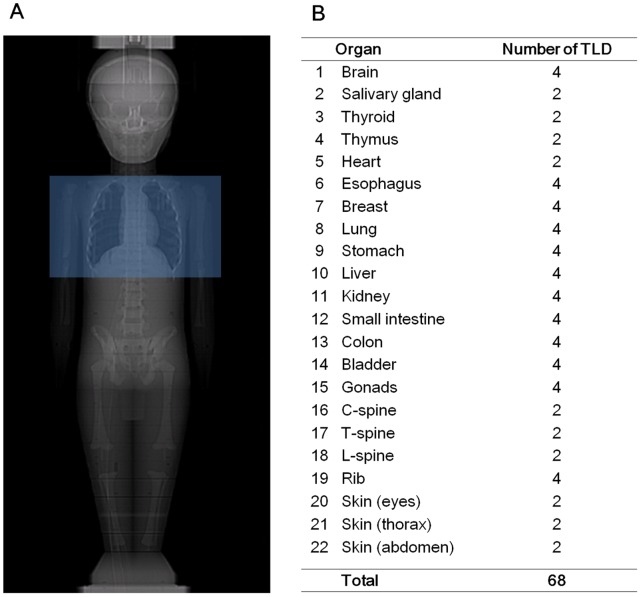
TLD locations in the anthropomorphic phantom.(A) The scan range included the entire lung from apex to base. (B) A total of 68 TLDs were placed at 22 phantom sites.